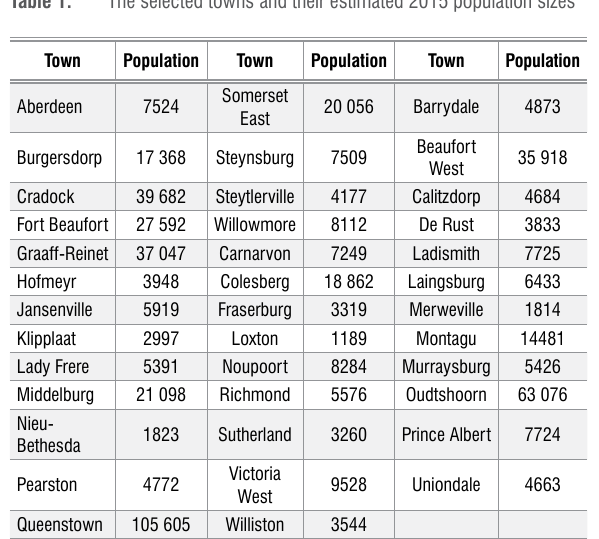
The selected towns and their estimated 2015 population sizes